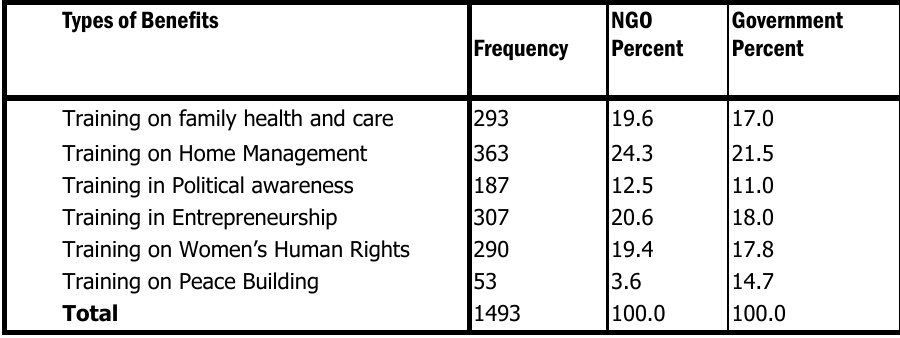
Table 5A: Type of benefit derived from the services of NGOs and Government Types of Benefits